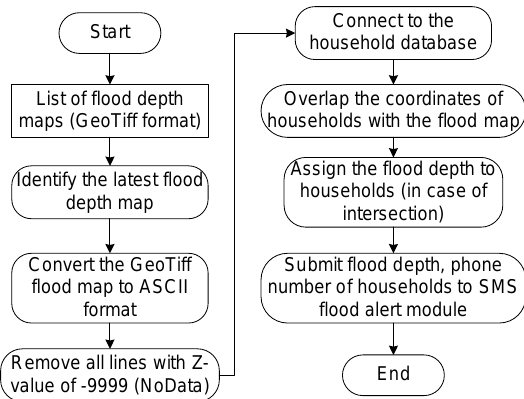
Figure 16. Operation process of household’s flood depth module.